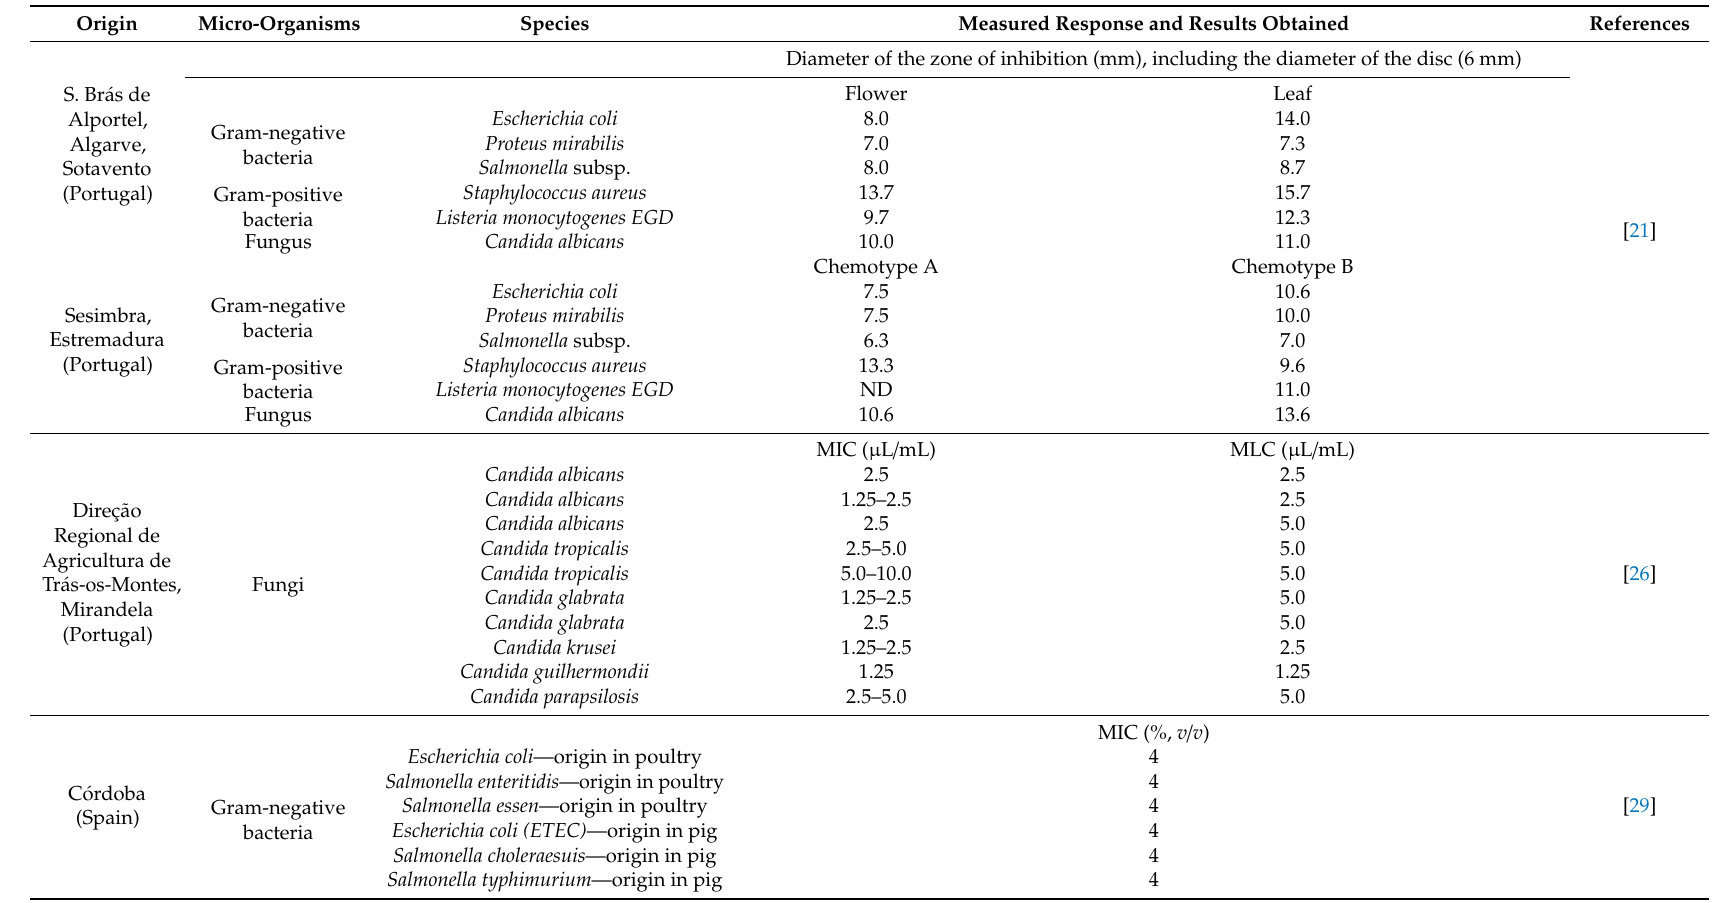
Table 2. Antibacterial and antifungal activity of Thymus mastichina essential oils and